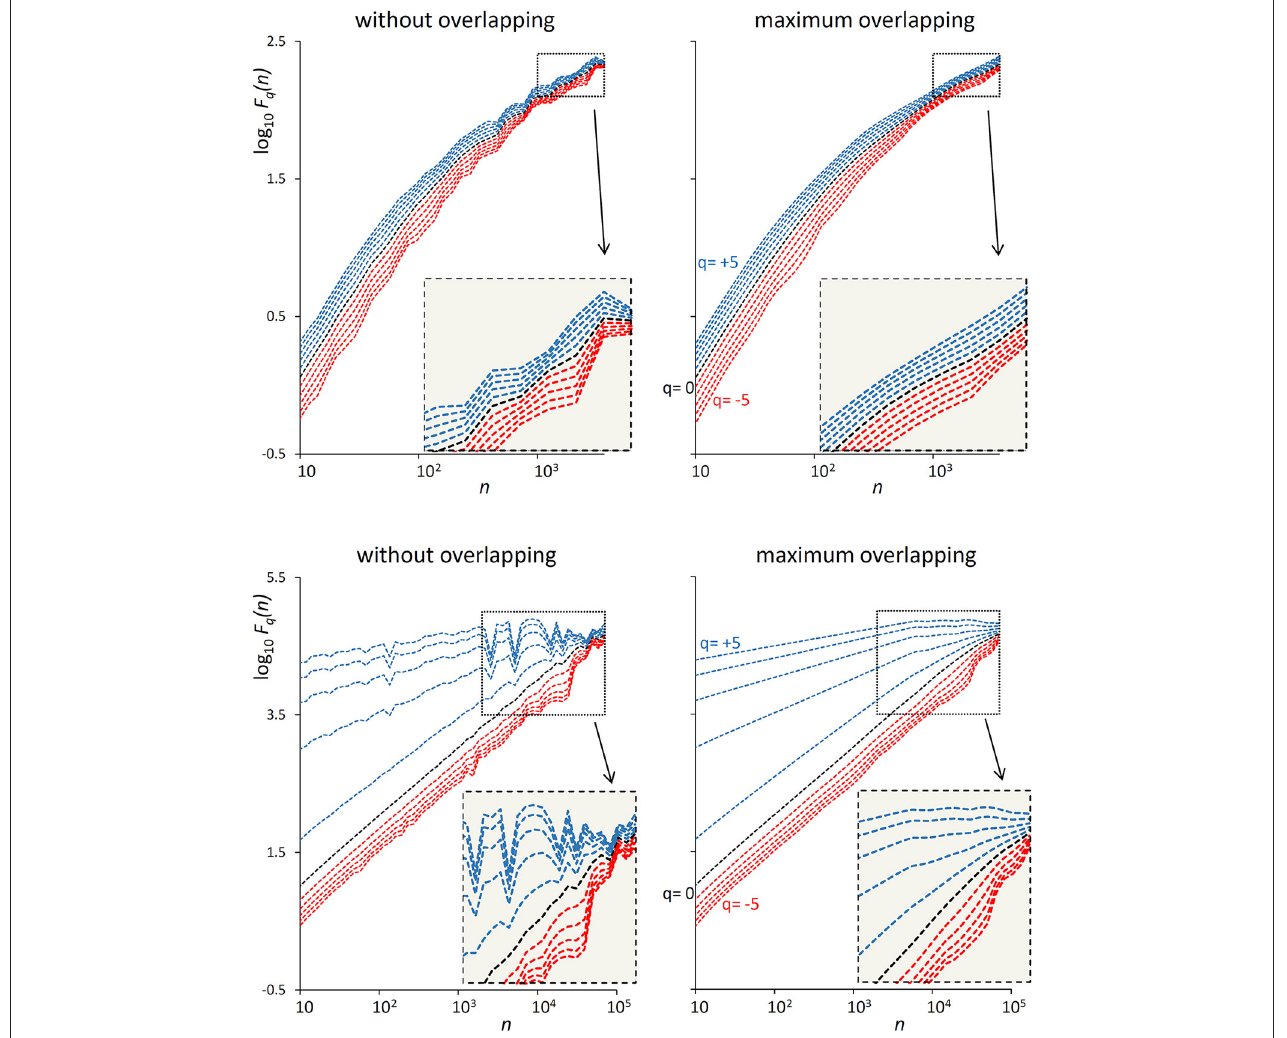
FIGURE 1 | Effect of blocks overlapping on variability and computation time of F q (n) estimates. (Upper) DFA 1 fluctuation functions for an autoregressive series { x i } of N = 16,384 samples generated as x i = ax i − 1 + wn i where wn i is white Gaussian noise with zero mean and unit variance and a = 0.9391014 as in Kiyono (2015), corresponding to a low-pass filter with cut-off frequency f co = 0.01, or a cross-over scale n co = 100 (Höll and Kantz, 2015); calculation time for estimating F q (n) over 38 block-sizes n was 4s without overlapping and 3min with maximum overlapping on a personal computer. (Lower) DFA 1 fluctuation functions for N = 300,000 random samples with Cauchy distribution (location 0, scale 3); calculation time for estimating F q (n) over 55 block-sizes n was 58s without overlapping, 5h and 22min with maximum